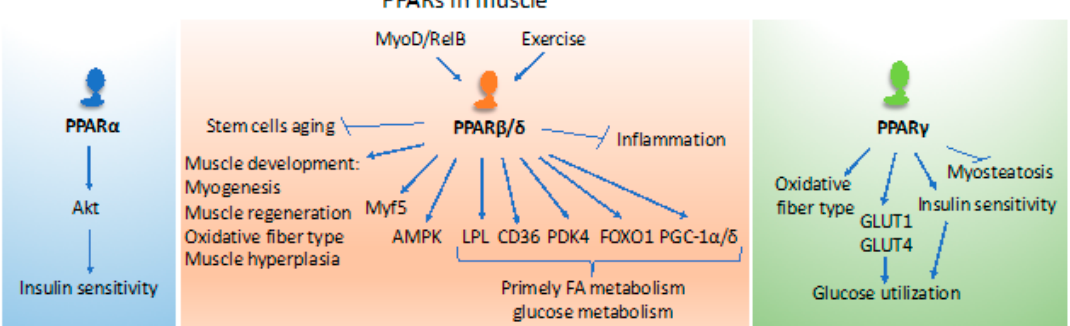
Figure 2. The roles of PPARs in the muscle. PPAR α impacts insulin sensitivity in muscles. PPAR β / δ plays multiple roles in muscle development, function, metabolism, and inflammation. The function of PPAR γ is mainly connected with metabolism and energy utilization. However, it also contributes to changes in muscle fiber type and inhibits myosteatosis. The list of depicted functions is not exhaustive and relates to the content of the review. PPAR: peroxisome proliferator-activated receptor; Akt: serine /